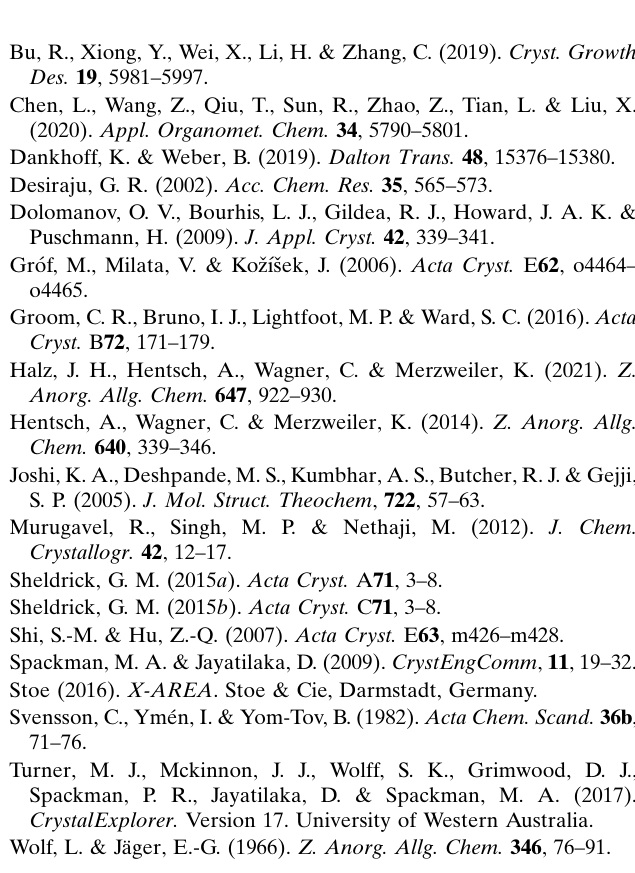
Table 7 Experimental details. Crystal data Chemical